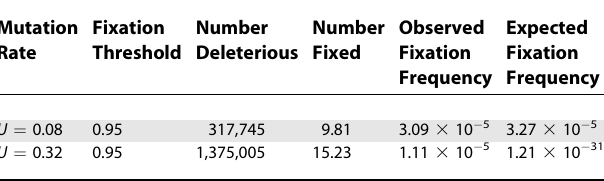
Table 2. The Probability of Fixation of Deleterious Mutations in Our Simulations Compared with Theoretical Predictions of Kimura (1957)